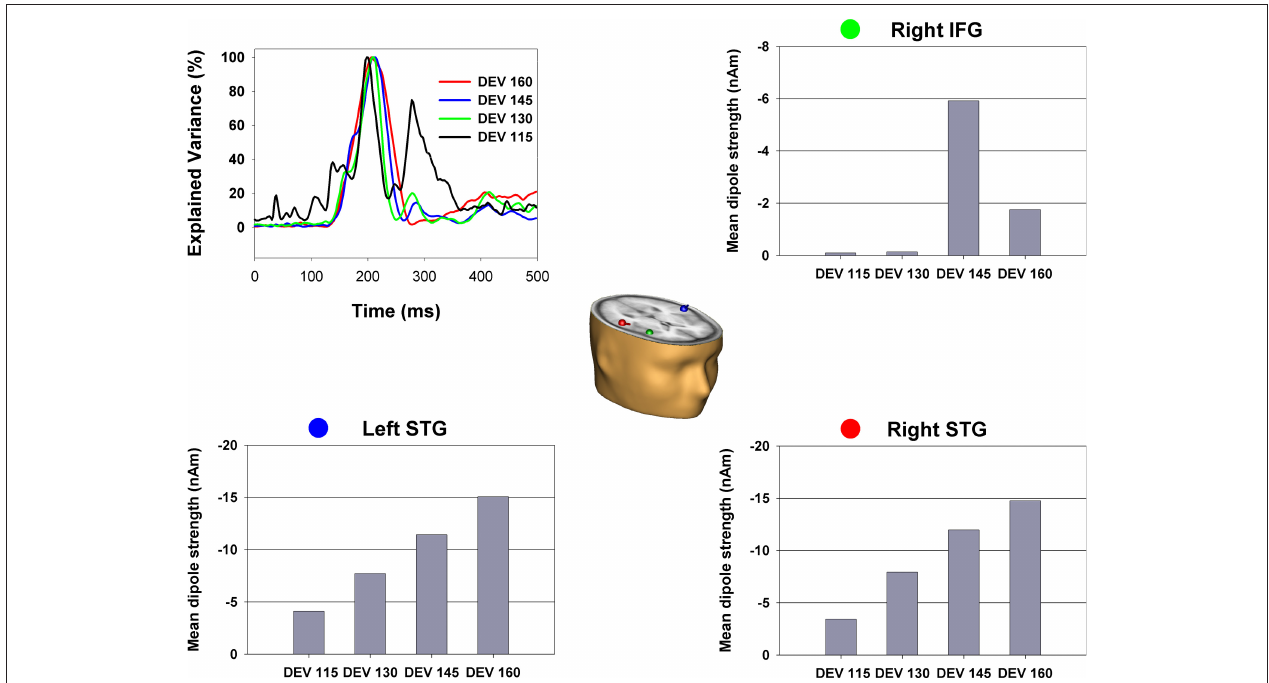
FIGURE 5 | The dipolar solution of the MMN component with sources bilateral in the superior temporal gyri and right inferior frontal gyrus. Dipoles are shown in the Talairach-transformed brain of an individual subject. Color dots by the graphs illustrating mean dipole strength indicate the corresponding color-